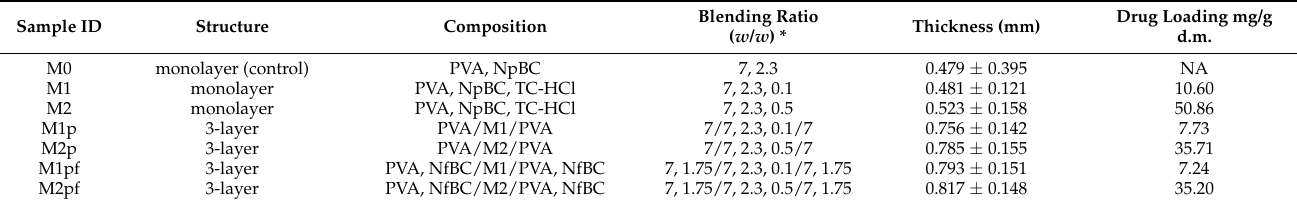
Table 1. Structure, composition, and thickness of composite